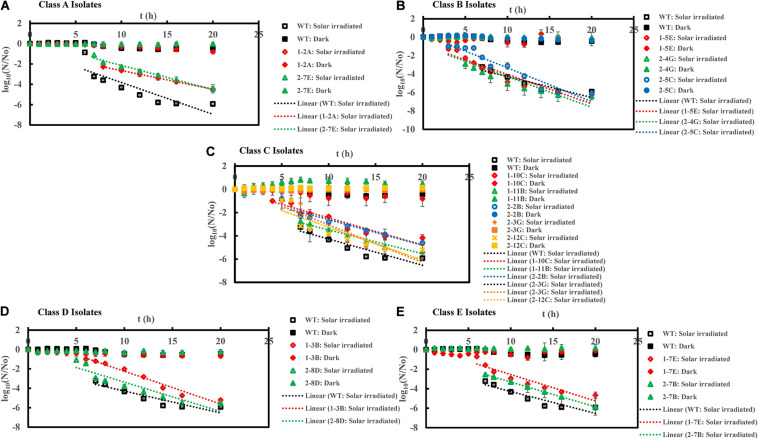
Inactivation curves of E. coli PI-7 WT and 5 categories of PI-7 transposon mutants exposed to simulated solar irradiation in buffer. Best-fit curves for simulated solar irradiation are reconstructed from the decay phase of inactivation curves. Half-lives derived from decay constants were also calculated from the portion corresponding to decay phase of solar irradiation in the inactivation curves. (A) Inactivation curves of PI-7 WT and resistant isolates (Class A isolates) exposed to simulated solar radiation; (B) Inactivation curves of PI-7 WT and susceptible isolates (Class B isolates) exposed to simulated solar radiation; (C) Inactivation curves of PI-7 WT and isolates with enhanced virulence (Class C isolates) exposed to simulated solar radiation; (D) Inactivation curves of PI-7 WT and isolates with enhanced oxidative stress response (Class D isolates) exposed to simulated solar radiation (E) Inactivation curves of PI-7 WT and isolates with enhanced motility and siderophore production (Class E) exposed to simulated solar irradiation.